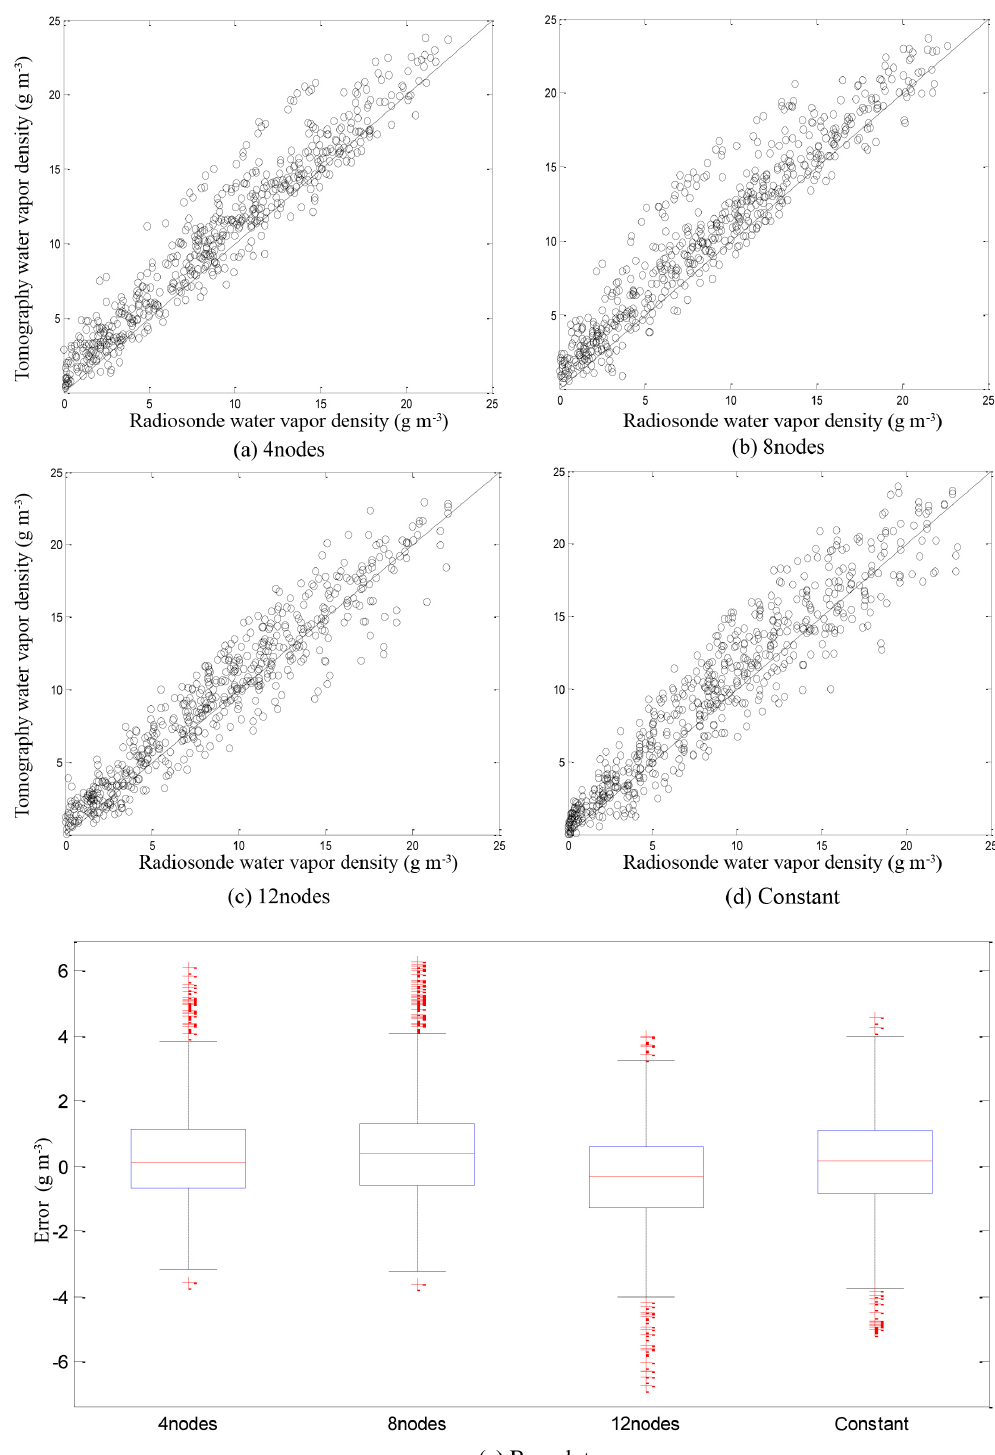
Figure 5. Tomographic solutions compared with radiosonde data. (a–d) Scatter plots of water vapor density with 4nodes, 8nodes, 12nodes, and constant parameterization and (d) box plots of the differences between the four methods and radiosonde data at 00:00 and 12:00UTC from 9 to 15 August